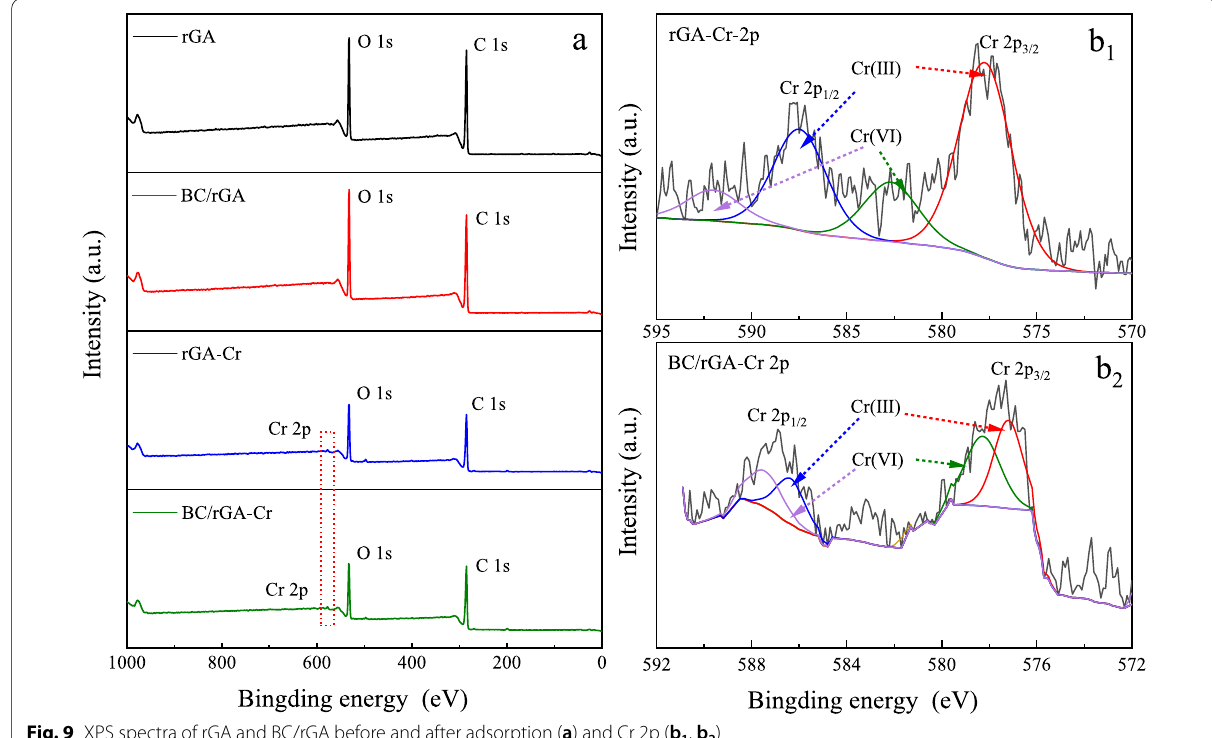
Fig. 9 XPS spectra of rGA and BC/rGA before and after adsorption ( a ) and Cr 2p ( b 1 , b 2